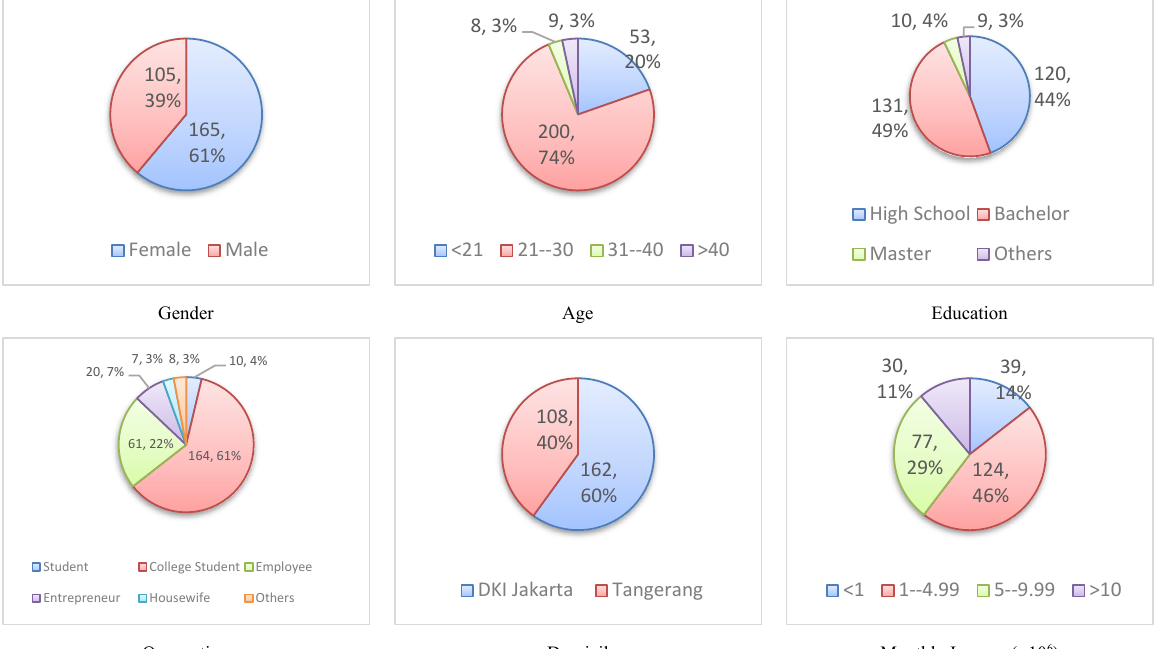
Fig. 1 is the profile of the respondents based on gender, age, level of education, occupation, domicile, and average monthly income. Out of the 287 samples gathered, 270 samples were used to take as per prior calculation.